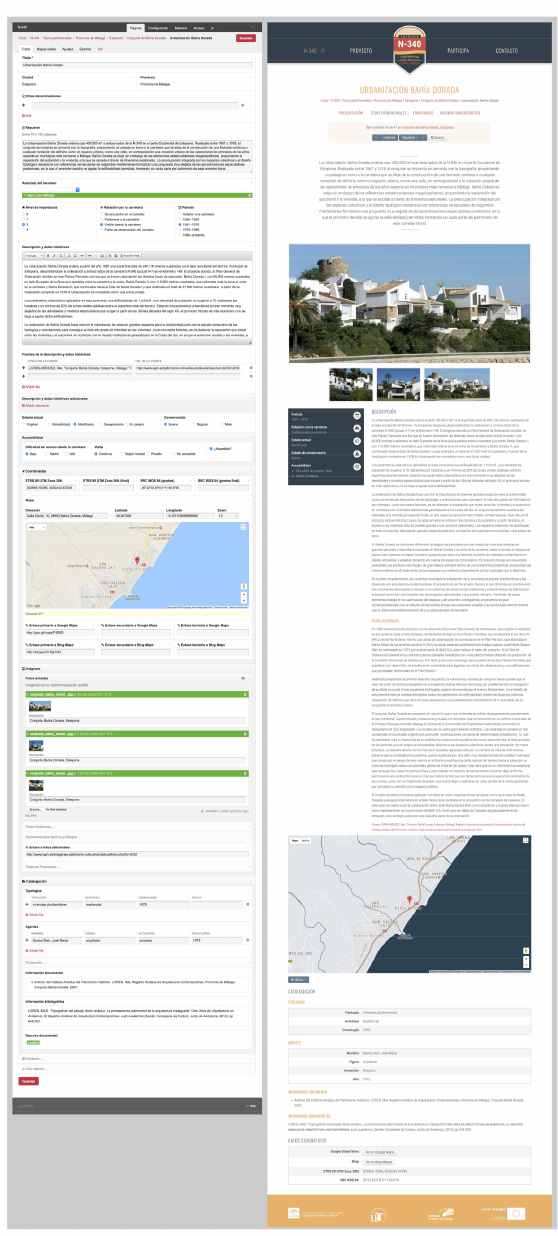
Figure 5. Back-end and front-end views of a heritage item. ( Left ) Heritage database: customized interface for researchers. Back-end view of the heritage asset of the corridor entitled “Urbanizaci ó n Bah í a Dorada”. ( Right ) Heritage database: interface for users. Front-end view of the same heritage asset (https://n-340.org/patrimonio/items-patrimoniales/malaga/estepona/conjunto- de-bahia-dorada/conjunto-bahia-dorada/). Screenshots by the N-340 research team, January